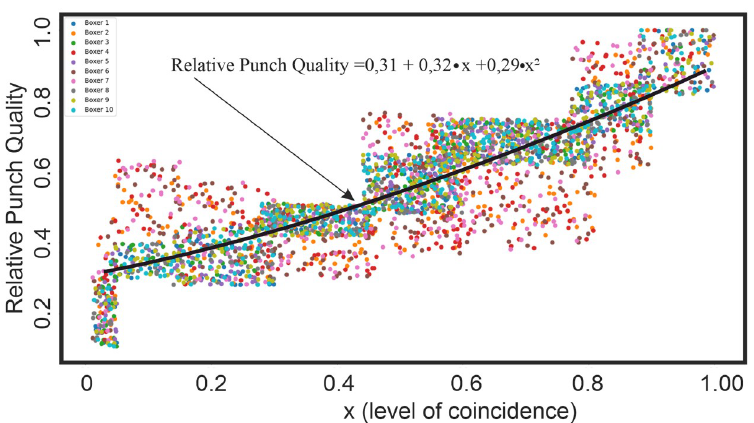
Fig 9. Dependence of the relative punch quality on the degree of coincidence of the punch quality and the model value.